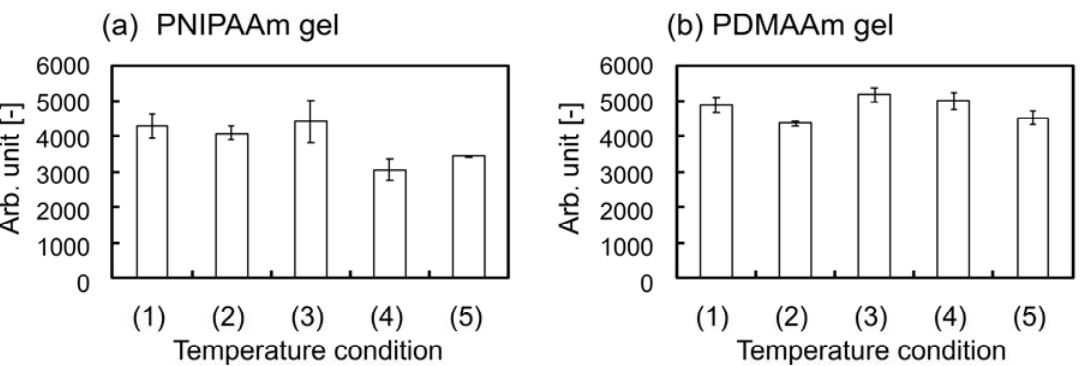
Figure 5. Fluorescence intensity showing the amount of accumulated lipid droplets inside cells obtained from the AdipoRed TM assay on ( a ) PNIPAAm gel and ( b ) PDMAAm gel. (1)–(5) show the temperature conditions for cell culture as explained in Figure 4. Data are expressed as the mean of three measurements (± standard